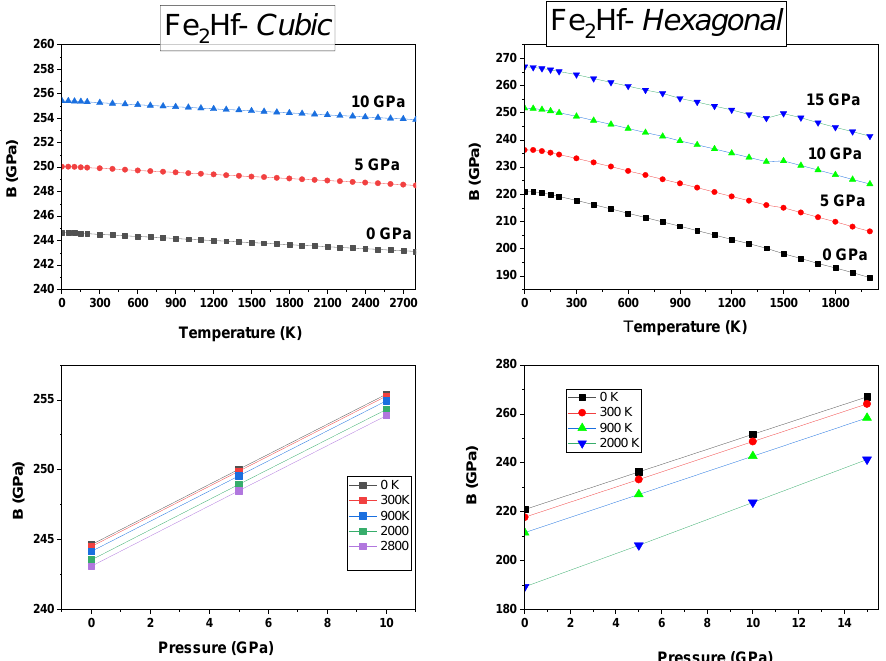
Fig. 7. Variation of bulk modulus with temperature T and pressures for c- Fe 2 Hf and h- Fe 2 Hf (upper panel)